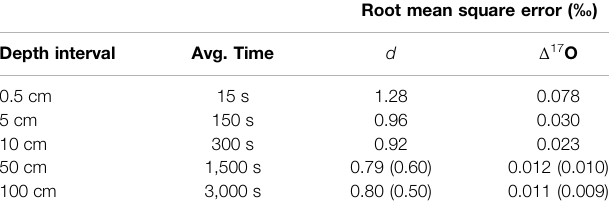
TABLE 5 | Root mean square error for deuterium excess ( d ) and 17 O excess ( Δ 17 O)betweenprimaryandreplicateicecoresamples,asafunctionofdepth- averaging window. Values in parentheses are for the measurements on discrete 1/2 m samples (red data in Figure 5 ). “ Avg. time ” is approximate time-average corresponding to each depth